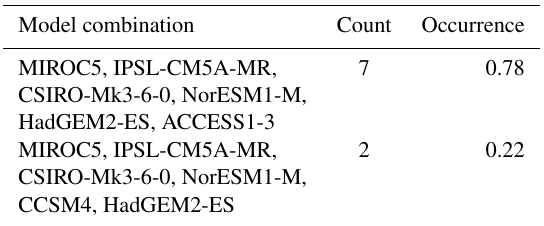
Table C7. Possible model combinations for the Greenland top six selection, with absolute and relative frequency of occurrence when applying the robustness test.